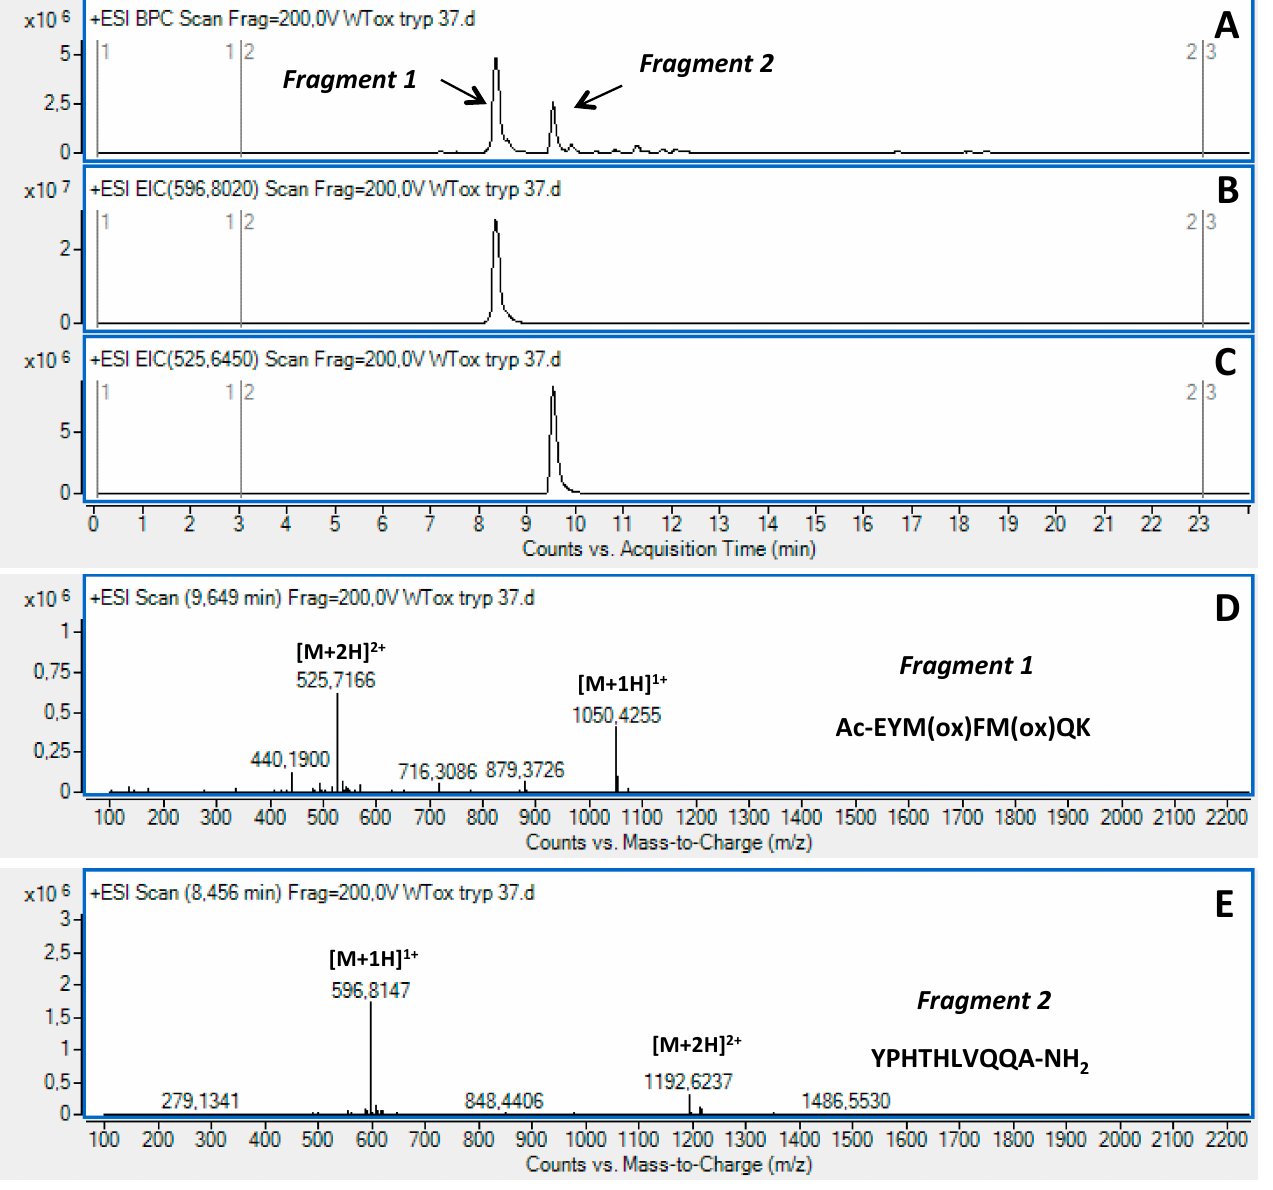
Figure 2. LC-MS analysis of GDF11[48-64]ox following tryptic digestion. Base peaks profiles of the peptide after oxidation and treatment with trypsin. ( A–C ) EIC analysis of Fragment 1 (Ac-EYMFMQK) and EIC analysis of Fragment 2 (YPHTHLVQQA-NH2). ( D ) Mass spectrum of Fragment 1. ( E ) Mass spectrum of Fragment 2. Table 1. Set of GDF11-related peptides containing methionine residues used as substrate models to evaluate the APEH endoprotease activity. Peptide sequences and their calculated (calcd.) and ex- perimental (expm.) MWs, as estimated by LC-ESI-TOF mass analyses, are reported. Mass values were obtained from the deconvoluted mass spectra. Methionines (M) and residues replaced in the mutated peptides are highlighted in bold.